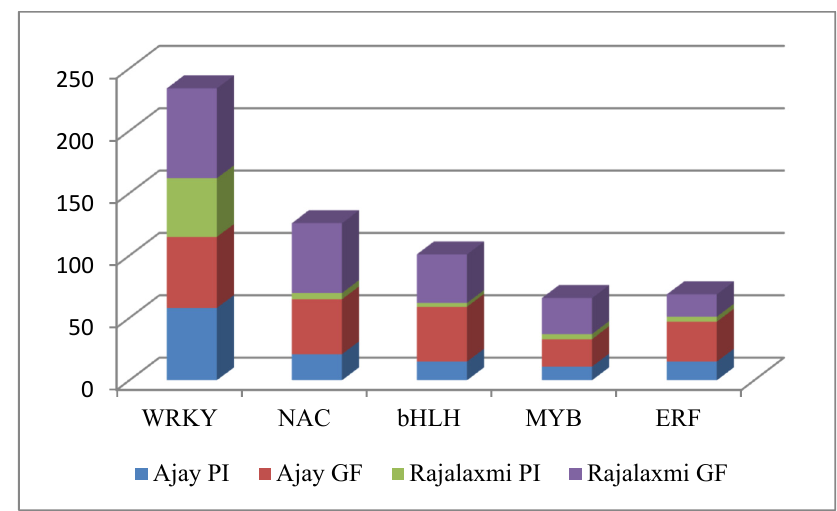
Figure 3. Kyoto Encyclopedia of Genes and Genomes (KEGG) pathway incident of panicle initiation and grain filling stage in Ajay hybrid. Figure 4. KEGG pathway incident of panicle initiation and grain filling stage in Rajalaxmi hybrid.